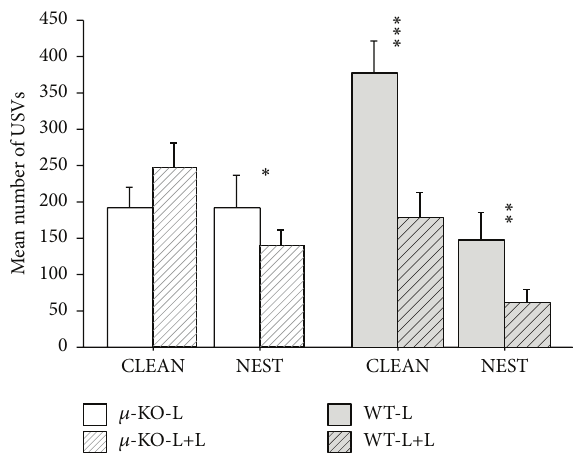
Figure 1: Mean number (+SEM) of ultrasonic vocalizations (USVs) emitted by 8-day-old pups of different experimental groups, when isolated in clean (CLEAN) or in their own home-cage (NEST) bedding for 5min. 𝑁 : 11–15 per group. 𝜇 -KO-L: Oprm1 −/− pups reared by their mother [CLEAN: 9 males + 6 females; NEST: 8 males + 5 females]; 𝜇 -KO-L+L: Oprm1 −/− pups reared by their mother plus a second lactating female [CLEAN: 4 males + 7 females; NEST: 6 males + 5 females]; WT-L: Oprm1 +/+ pups reared by their mother [CLEAN: 8 males + 6 females; NEST: 4 males + 8 females]; WT- L+L: Oprm1 +/+ pups reared by their mother plus a second lactating female [CLEAN: 7 males + 6 females; NEST: 6 males + 6 females]. Discrimination of clean versus nest bedding: ∗ 𝑝 < 0.05 , ∗∗ 𝑝 < 0.01 , and ∗∗∗ 𝑝 < 0.001 .